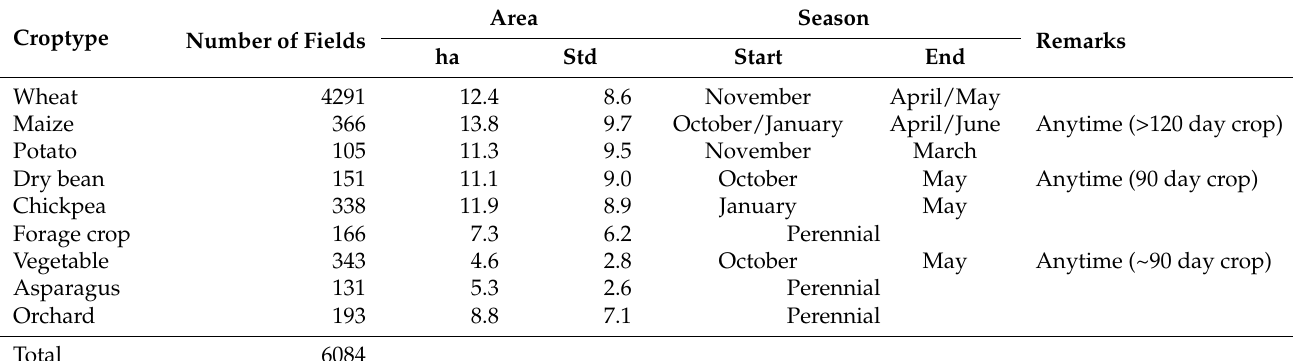
Table 1. Summary of the labeled in situ data generated for the crop classification study in the Yaqui Valley (Mexico) for the 2016–2017 growing season. The table shows the average area in hectares (ha) and standard deviation (Std) of the fields of each crop type, as well as the growing period.